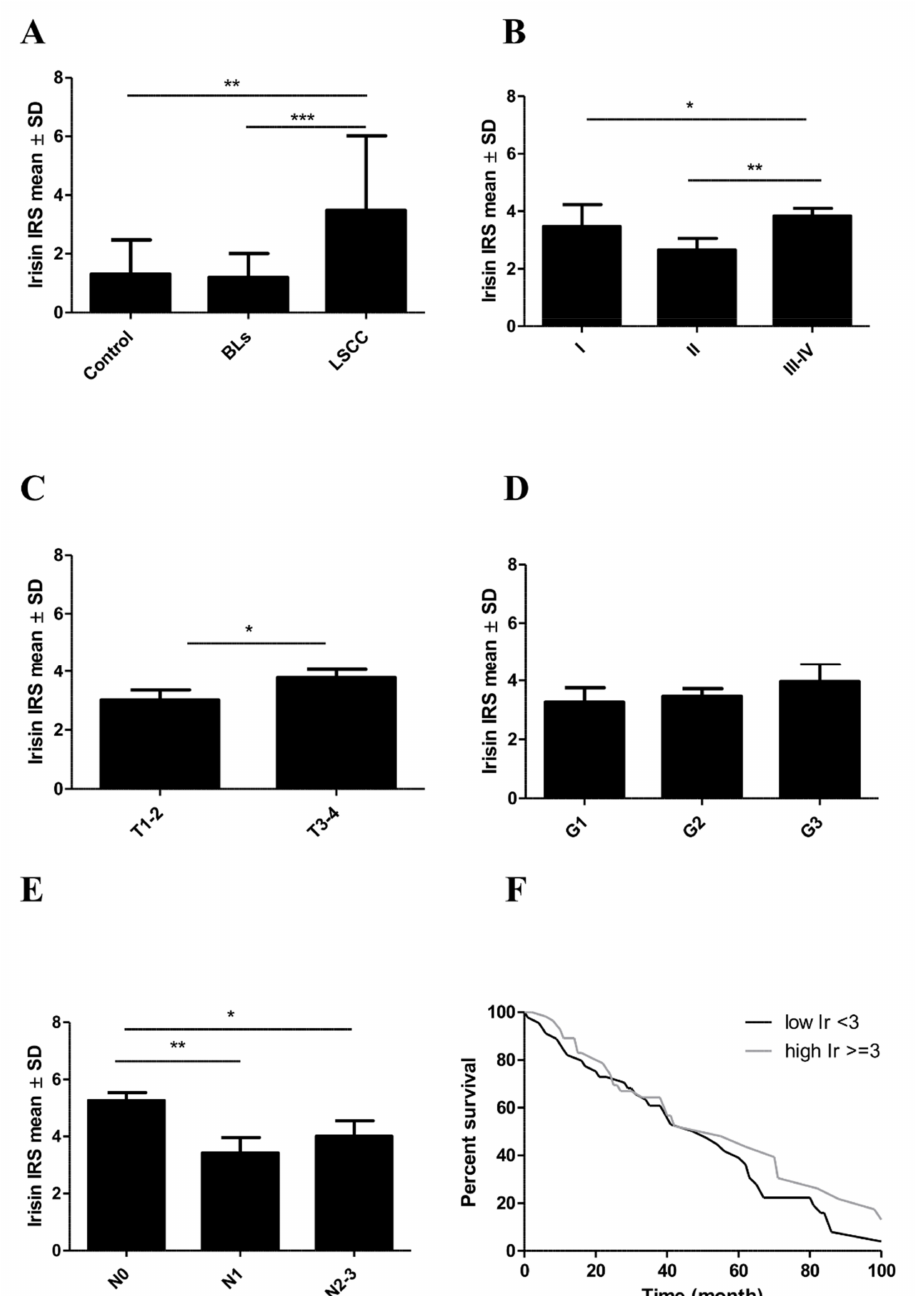
Figure 2. Comparison of irisin expression levels detected by immunohistochemistry (IHC) in control tissues, benign lesions (BLs), and laryngeal squamous cell cancer (LSCC) ( A ). Comparison of irisin expression levels in LSCC cells according to the tumor stage ( B ), tumor size ( C ), the grade of malignancy ( D ), and the lymph node status ( E ). Kaplan–Meier survival curves show the prognostic impact of irisin expression levels on overall survival (OS) of patients with LSCC. Patients were grouped according to the median value of expression levels ( F ), * p ≤ 0.05, ** p ≤ 0.005, *** p ≤